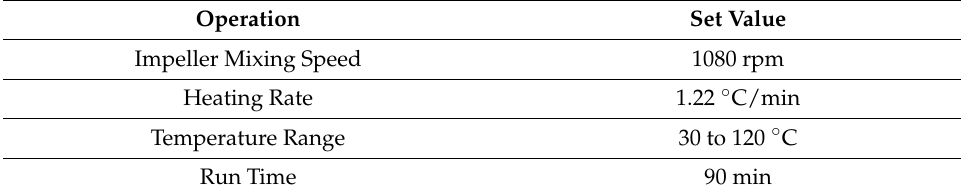
Table A3. CREC-VL-Cell Operational